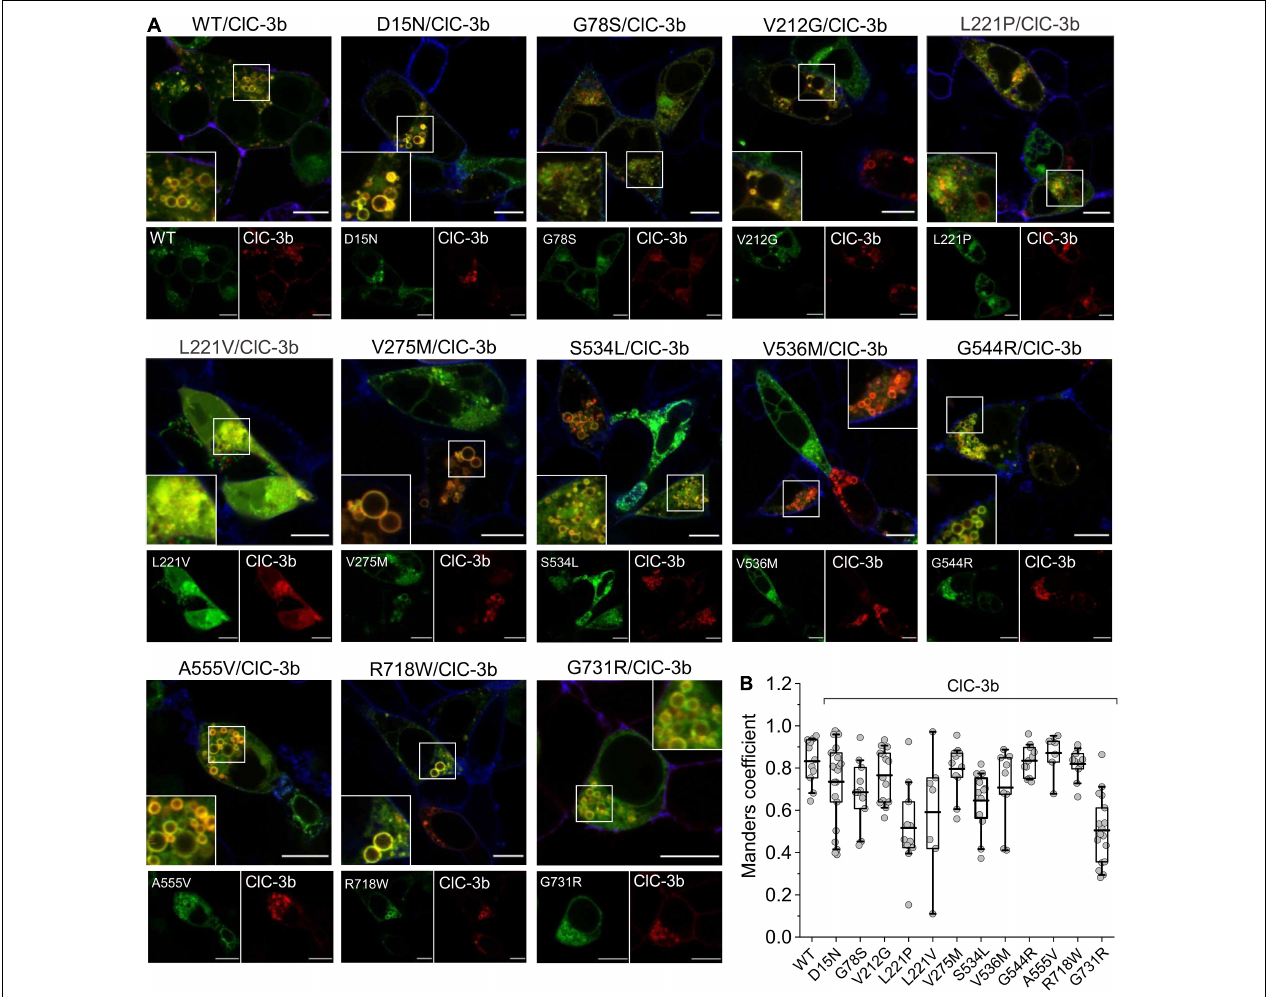
FIGURE 8 | Subcellular localization of ClC-3b/ClC-4 (WT and mutant) heterodimers. (A) Representative confocal images of HEK293T cells co-expressing WT or mutant ClC-4 together with ClC-3b. ClC-4 was tagged with eGFP and ClC-3b with mCherry. Inset shows areas outlined in the white boxes. (B) Mean values of Mander’s overlapping coefficient analyses. (WT, n = 11; D15N, n = 21; G78S, n = 11; V212G, n = 14; L221P, n = 11; L221V, n = 7; V275M, n = 11; S534L, n = 12; V536M, n = 9; G544R, n = 11; A555V, n = 7; R718W, n = 11; G731R, n = 17). ClC-4 mutants plus ClC-3b were compared with WT ClC-4 plus ClC-3b using one-way analysis of variance (with Tukey’s HSD post hoc testing). Data were obtained from three or four independent transfections and are presented as boxplot boxes indicating upper and lower quartiles; whiskers indicate upper and lower 90%. Scale bar represents 10 µ